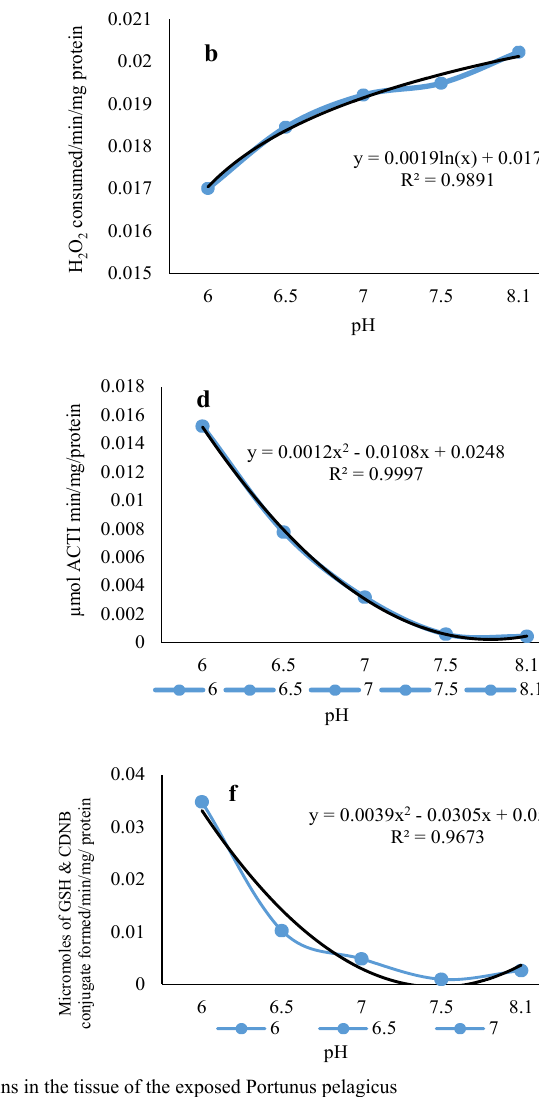
Fig 4: a) Effects of reduced pH on level of proteins in the tissue of the exposed Portunus pelagicus b) Effects of reduced pH on CAT levels in the tissue of the exposed Portunus pelagicus c) Effects of reduced pH on LPx levels in the tissue of the exposed Portunus pelagicus d) Effects of reduced pH on AChE levels in the tissue of the exposed Portunus pelagicus e) Effects of reduced pH on GSH levels in the tissue of the exposed Portunus pelagicus f) Effects of reduced pH on GST levels in the tissue of the exposed Portunus